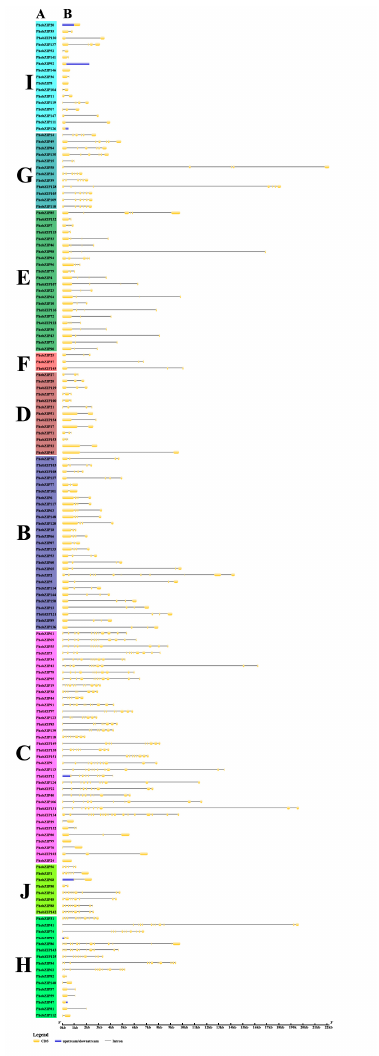
Figure 2. Unrooted tree of the PhebZIP gene family and exon / intron organization of moso bamboo ( Phyllostachys edulis ) bZIP proteins. ( A ) The numbers above or below branches on the phylogenetic tree indicate node bootstrap values are based on 1000 replicates. The unrooted tree was constructed with MEGA v. 6.0 software by the Neighbor-Joining (NJ) method with 1000 bootstrap replicates. The middle set of numerals on the tree represent eight PhebZIP groups. ( B ) Yellow rectangles represent exons, grey lines represent introns, and blue boxes represent untranslated regions